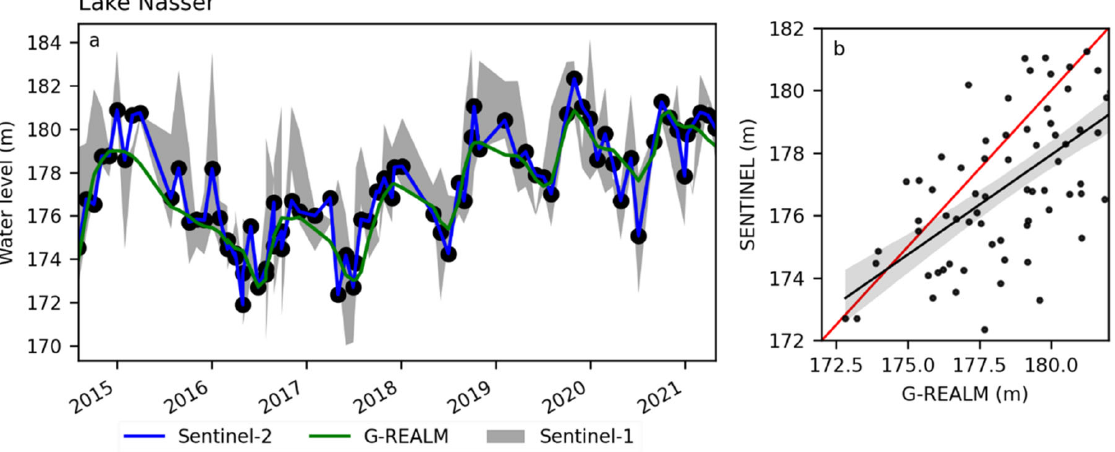
Figure 6. ( a ) Water levels estimated using contour matching from SRTM DEM with surface water extent derived from Sentinel-1, Sentinel-2, and G-REALM for Lake Nasser. The band of values for Sentinel-1 represents the water levels derived from threshold values ranging from − 15 to − 20 dB for the extraction of water masks. ( b ) Scatter plot showing the relationship between water levels estimated from Sentinel vs. G-REALM data. Table 3. Average water levels derived from the two sources for Lake Nasser.